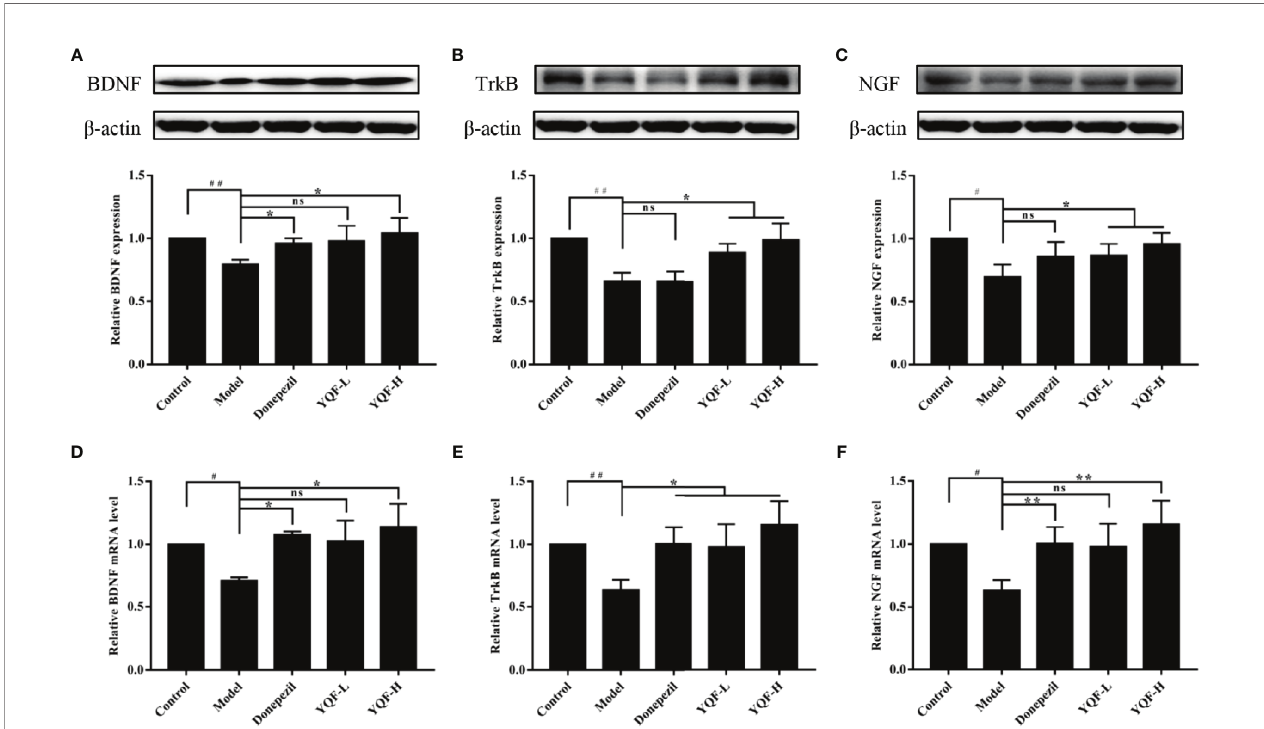
FIGURE 7 | Effect of YQF extract on the expression of BDNF, TrkB and NGF. (A) YQF extract increased BDNF expression. (B) YQF extract increased TrkB expression. (C) YQF extract increased NGF expression. (D) Quantitative analysis of BDNF mRNA by RT-PCR. (E) Quantitative analysis of TrkB mRNA by RT-PCR. (F) Quantitative analysis of NGF mRNA by RT-PCR. The results were obtained from three independent experiments. The data are expressed as mean ± SEM, n = 4. # p < 0.05, ## p < 0.01, compared with control group; * p < 0.05, ** p < 0.01, compared with Model group. ns, no signi fi cant difference.